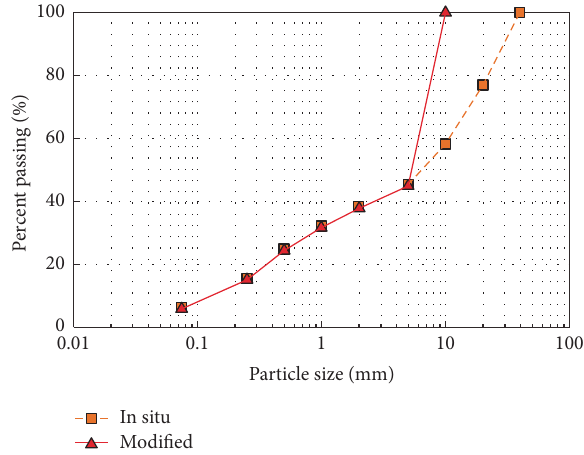
Figure 2: Grain size distribution of the material.